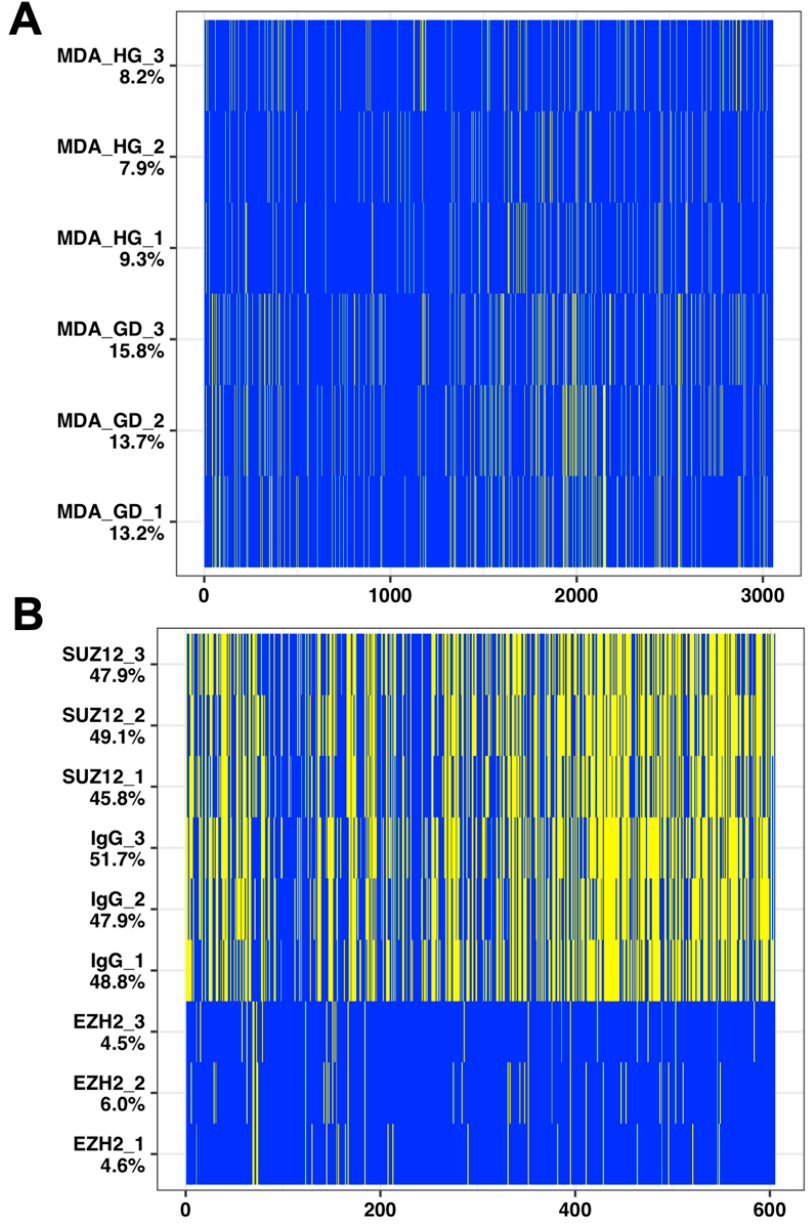
Figure 2. Distribution of number of missing values in the two datasets analyzed for this manuscript. The MDA data ( A ) are very similar in terms of the number of missing values (depicted as yellow lines) ranging from 8 to 14% relative to observed values (depicted as blue lines), while the IP data ( B ) demonstrates a presence/absence dataset with missing values ranging from 5 to 52%.